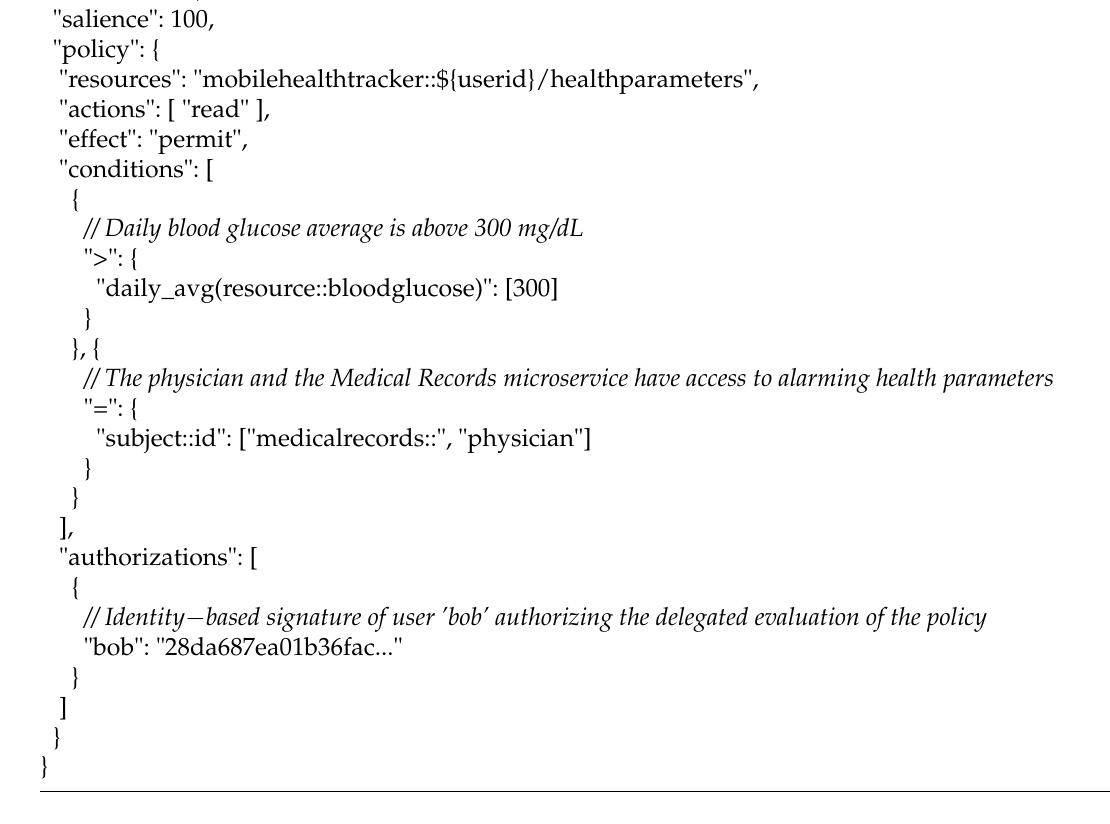
Figure 13. User ‘bob’ authorizing the delegated evaluation of data-driven authorization